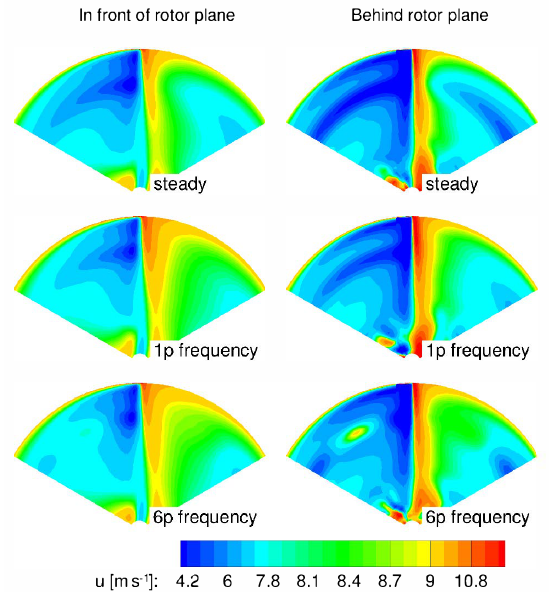
Figure 14. Extracted AoA according to Johansen and Sørensen (2004). Figure 15. Flow field extracted at one local chord distance in front of and behind the rotor blade for β = 10 ◦